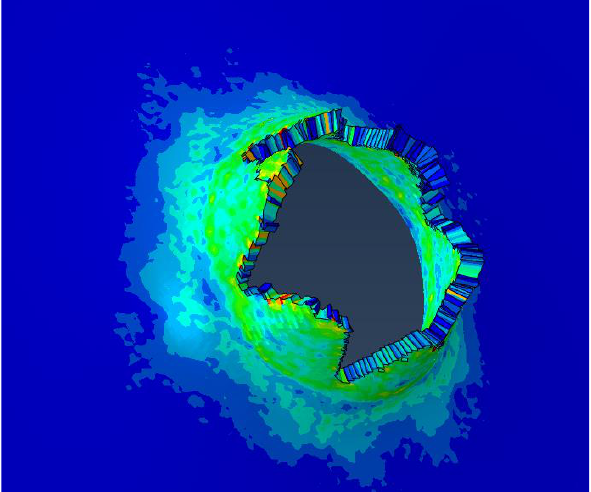
Figure 5. Simulation results for a launch speed of 42 m/s: ( a ) before penetration; ( b ) penetrating; ( c ) no penetration.